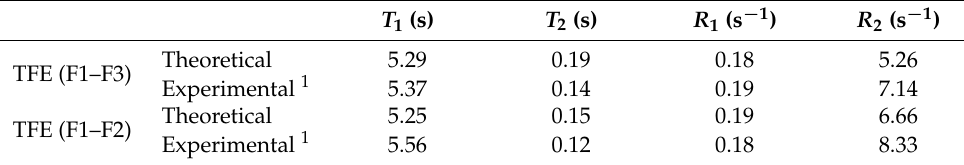
Table 5. Theoretical and experimental relaxation time